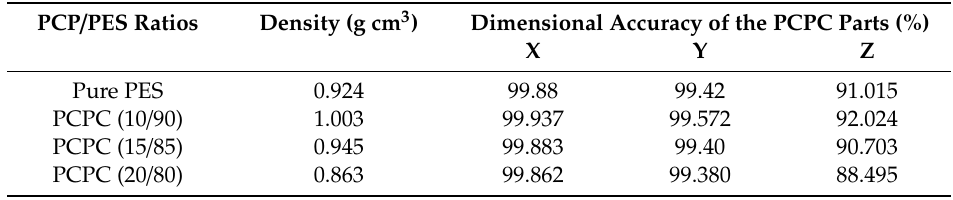
Table 1. The density and dimensional accuracy of the pure PES and PCPC parts with varying PCP / PES ratios.